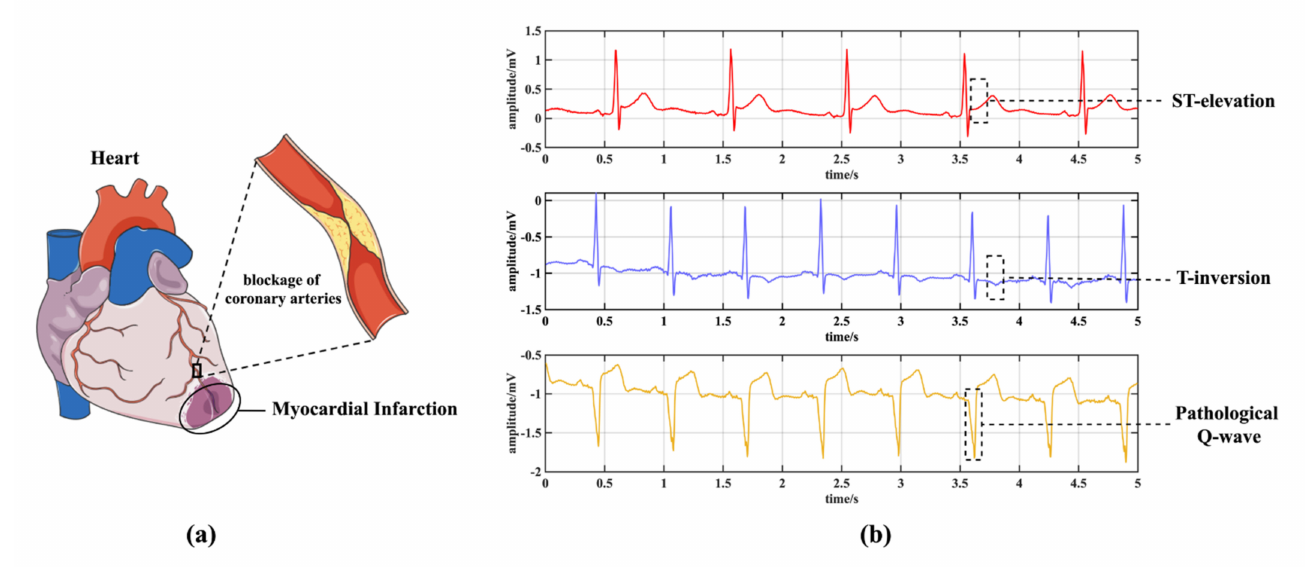
Figure 1. An introduction for MI. ( a ) The causes of MI. ( b ) The typical waveforms of